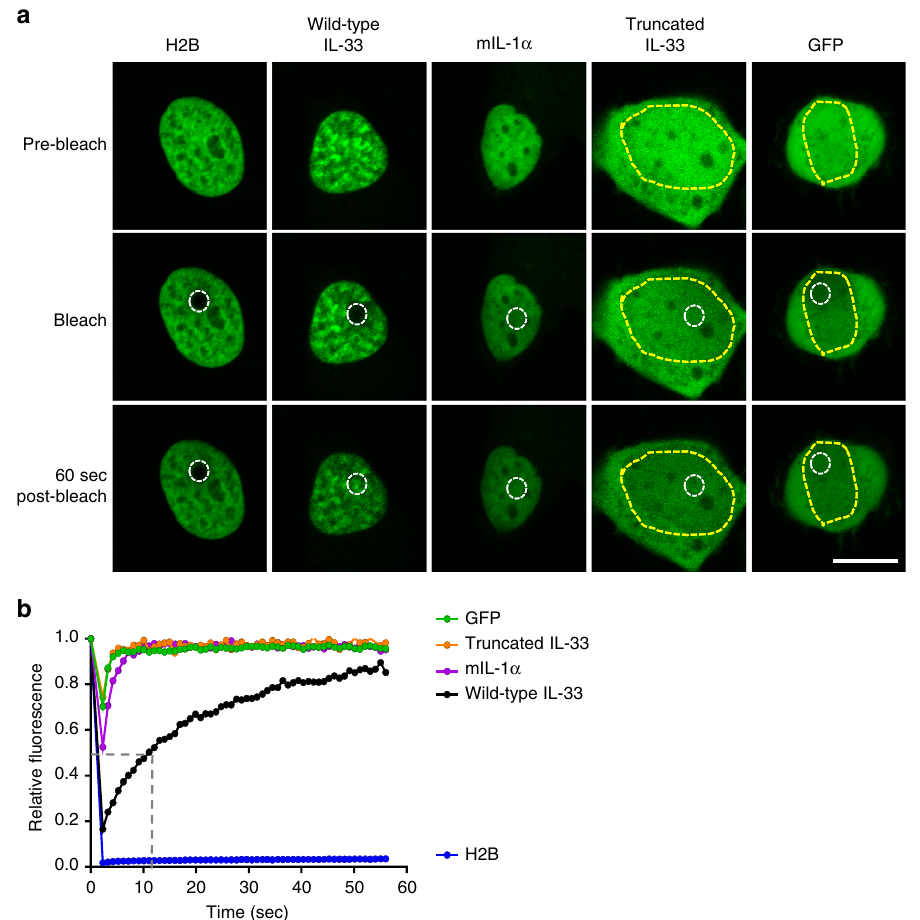
Fig. 4 IL-33 dynamically binds to chromatin. a Fluorescence recovery after photobleaching (FRAP) was performed on TE-7 cells after transient transfection with plasmid encoding the indicated GFP-fusion proteins. A region of interest (ROI) (white dashed lines) was bleached, and fl uorescence within that ROI was determined continuously over the following 60 s. Representative images of GFP fl uorescence (green) from before bleach (top row), immediately after bleach (middle row), and 60 s post-bleach (bottom row) are shown for the indicated GFP-fusion protein. For GFP-fusion proteins with signi fi cant cytoplasmic localization, the nucleus is outlined with yellow dashed lines. Scale bar is 10 μ m. b Representative FRAP experiment showing fl uorescence within ROI during bleach and for 60 s post-bleach for each GFP-fusion protein. Dashed gray lines indicate 50% recovery for wild-type IL-33 – GFP.